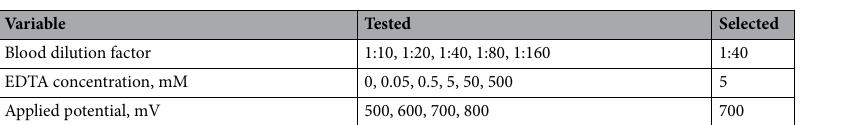
Variable Tested